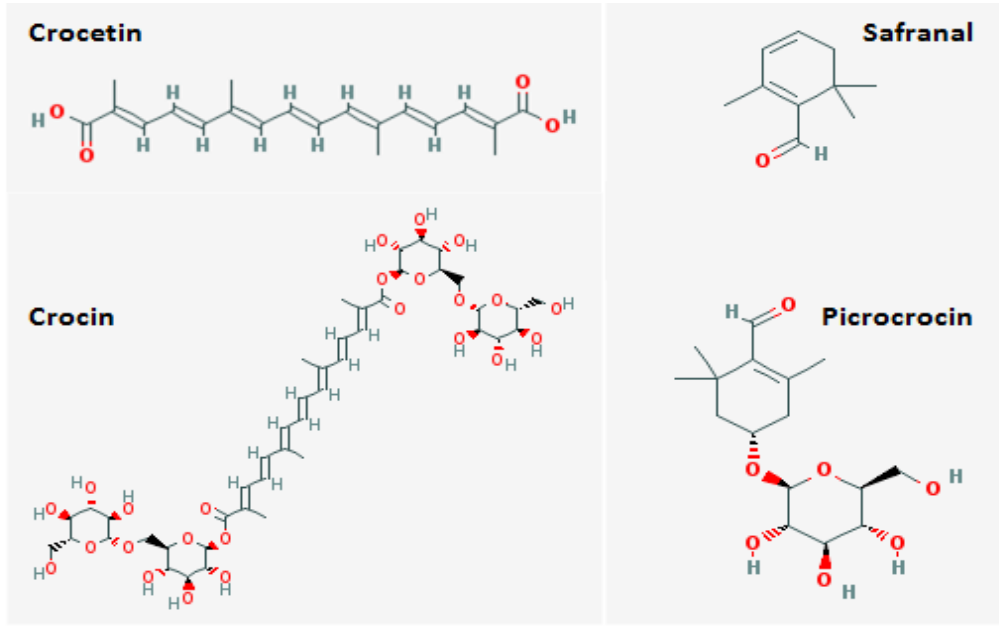
Figure 1. Chemical composition of the most active constituents of